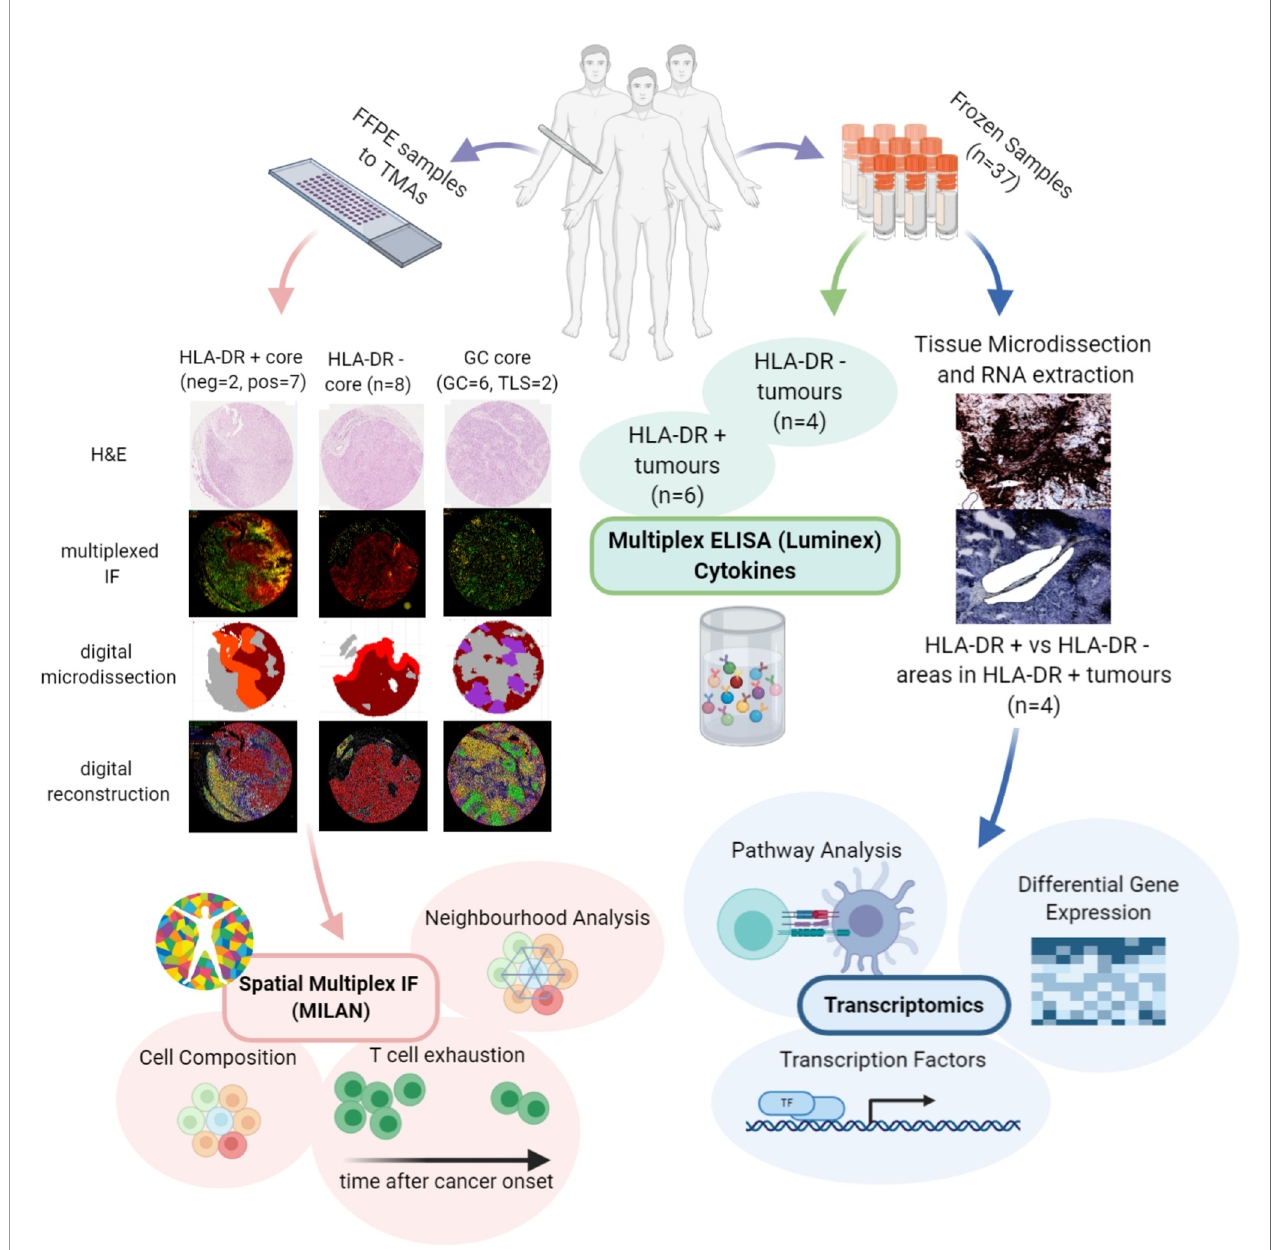
FIGURE 1 | Investigation of the microenvironment of HLA-DR positive metastatic melanoma samples using multi-omics approach. FFPE samples from patients expressing HLA-DR+ metastatic melanoma were selected and transferred to TMAs. Then, MILAN was performed on HLA-DR+ and HLA-DR- areas in order to characterize the immune microenvironment at single-cell level. The data extracted allowed investigating the cell composition, performing the neighborhood analysis and revealed presence of T cell exhaustion. The cell composition and neighborhood analyses was repeated for germinal centers/tertiary lymphoid structures to provide more evidence about the similarity between the features characterizing the immune microenvironment of HLA-DR + and HLA-DR- areas and the germinal centers. In parallel, Multiplexed immunohistochemistry was applied to the frozen samples of HLA-DR+ tumors to reveal HLA-DR+ regions. The regions were micro dissected to compare Pos and NegInPos areas of selected cases with adequate RNA quality. Gene expression analysis, transcription activity and pathway analysis revealed signatures related to both pro-in fl ammatory and anti-in fl ammatory roles and an upregulation of multiple biological pathways primarily involving the immune system function. Finally, multiplexed ELISA was performed on HLA-DR+ and HLA-DR- tumors taken from the frozen sample dataset to investigate which cytokines predominantly drive the composition of the tumour microenvironment.